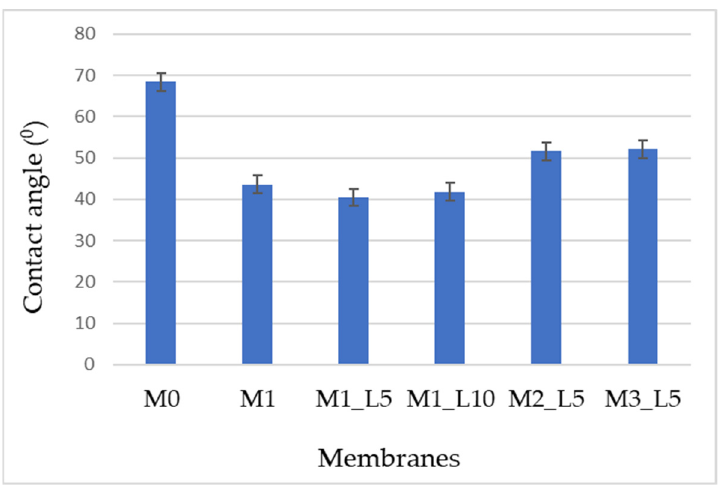
Figure 3. Contact angles for the prepared membrane. All results are significantly different from each other ( p < 0.05).